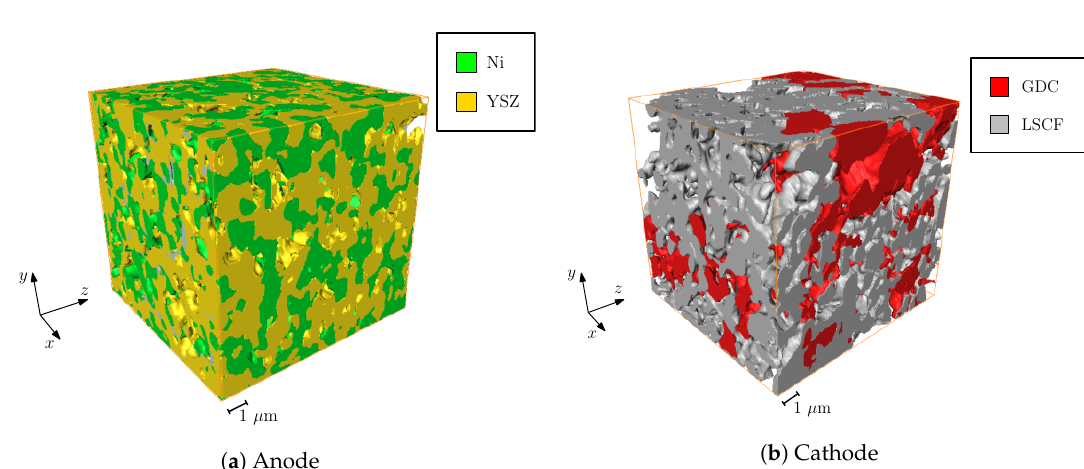
Figure 7. Three-dimensional reconstruction of the anode and cathode. Table 4. Sample sizes and voxel sizes.